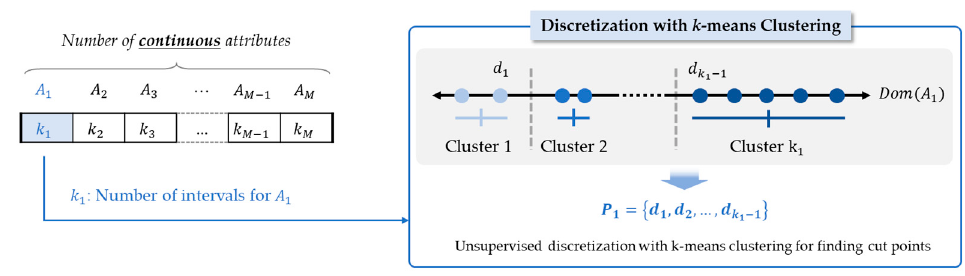
Figure 3. Chromosome representation.